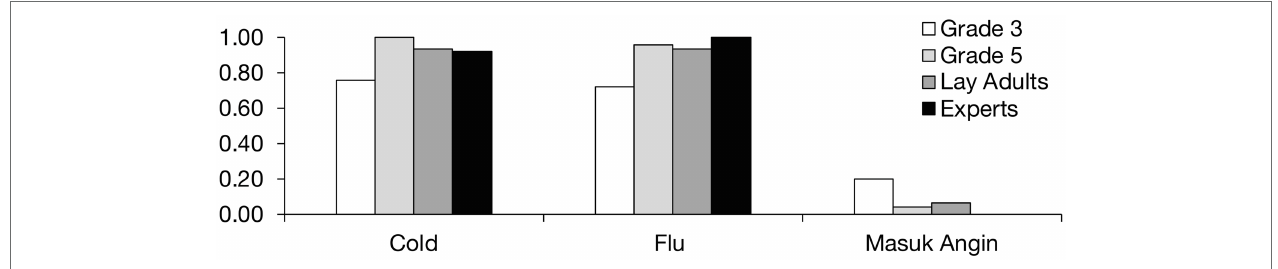
FIGURE 2 | Proportion of participants who asserted that each illness is